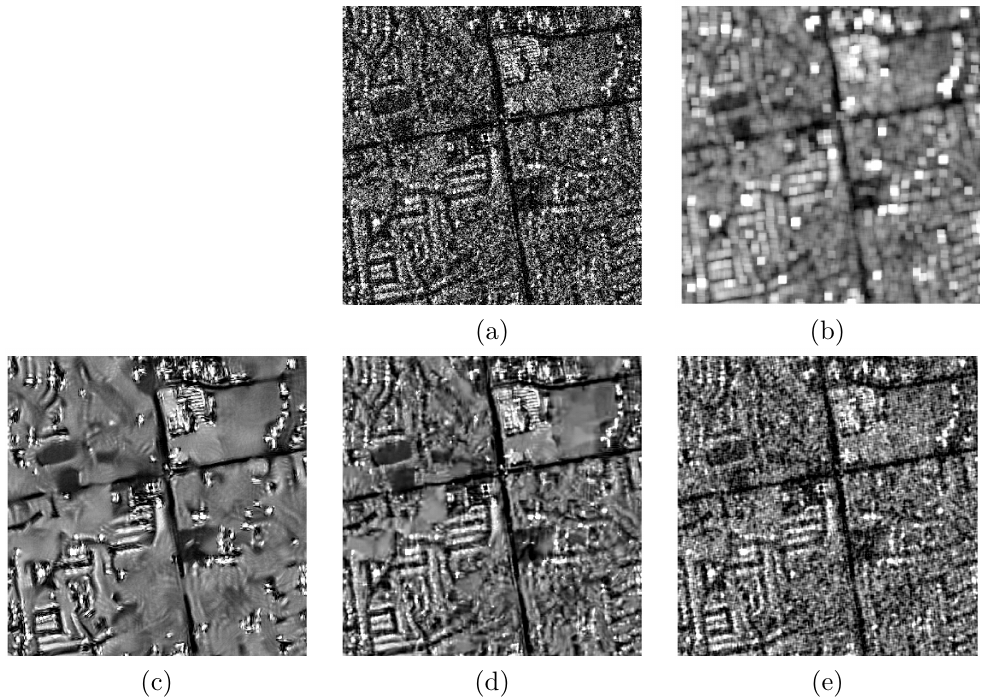
Figure 18. Chicago test case. Zoom of a selected area obtained for: ( a ) Noisy SAR data, ( b ) Kuan, ( c ) PPB-it, ( d ) FANS, and ( e )